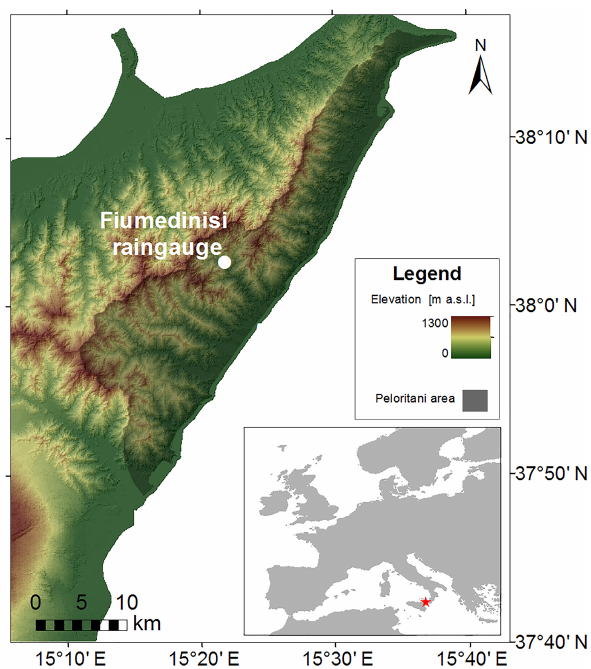
Figure 1. Location of the Peloritani Mountains area in Sicily, Italy, and of the Fiumedinisi rain